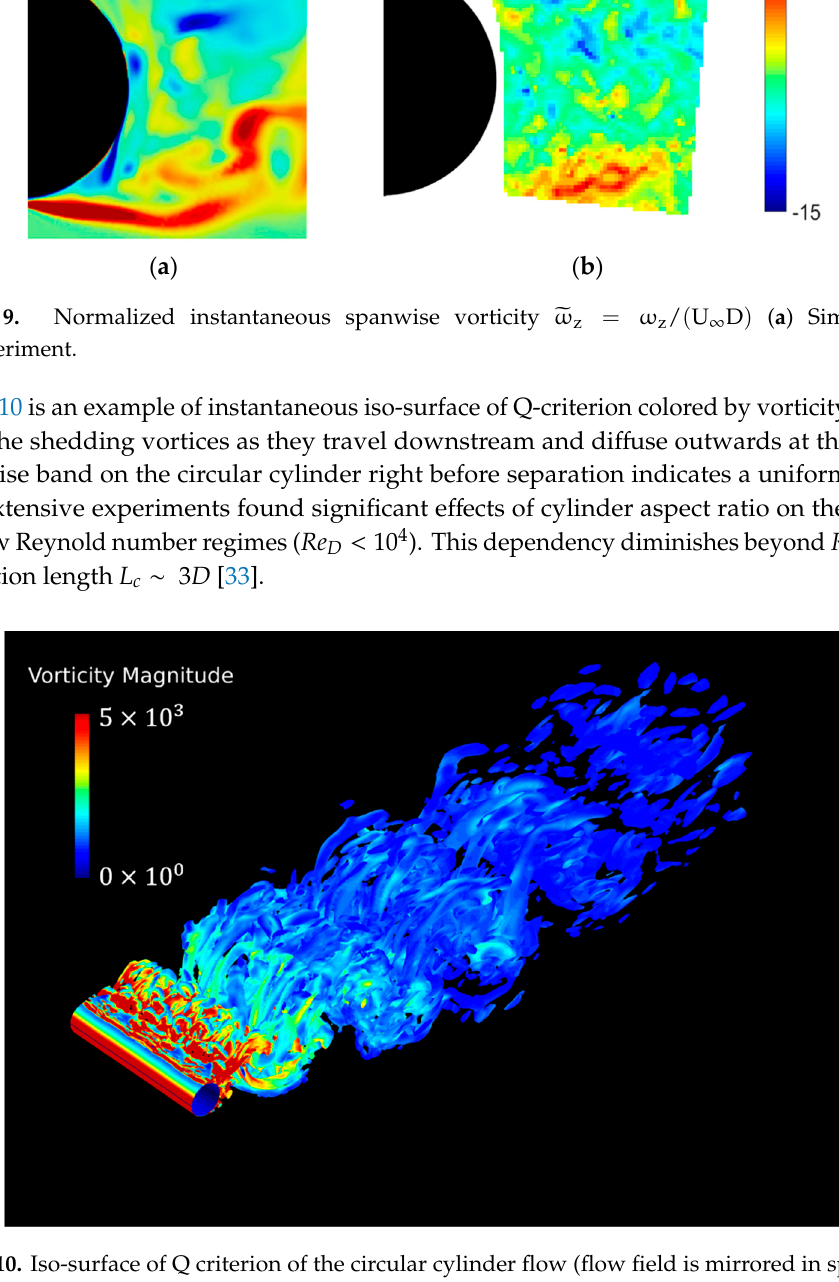
Figure 10. Iso-surface of Q criterion of the circular cylinder flow (flow field is mirrored in spanwise direction).